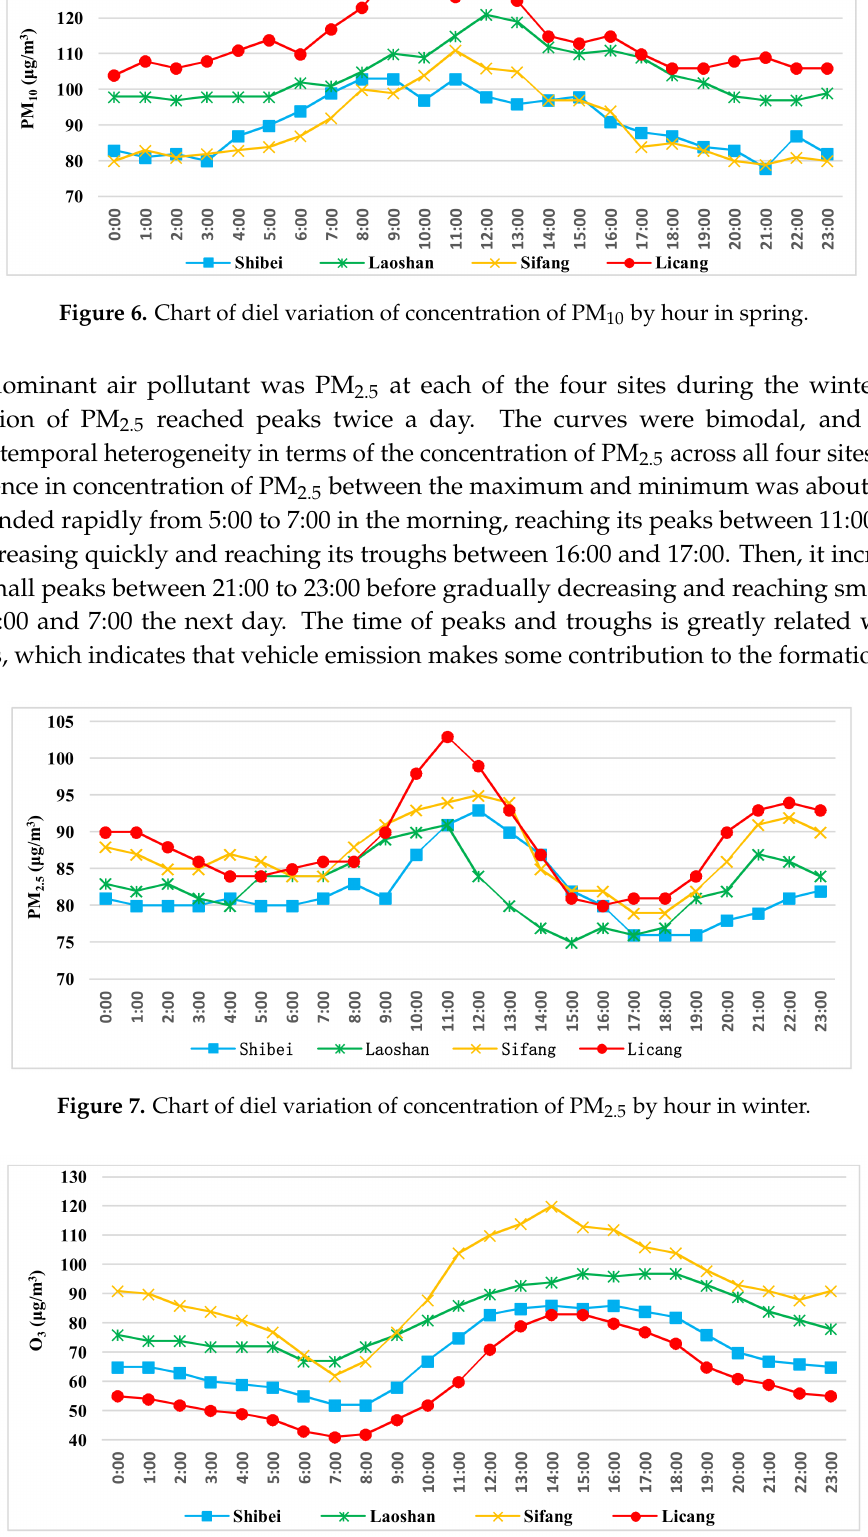
Figure 8. Chart of diel variation of concentration of O 3 by hour in